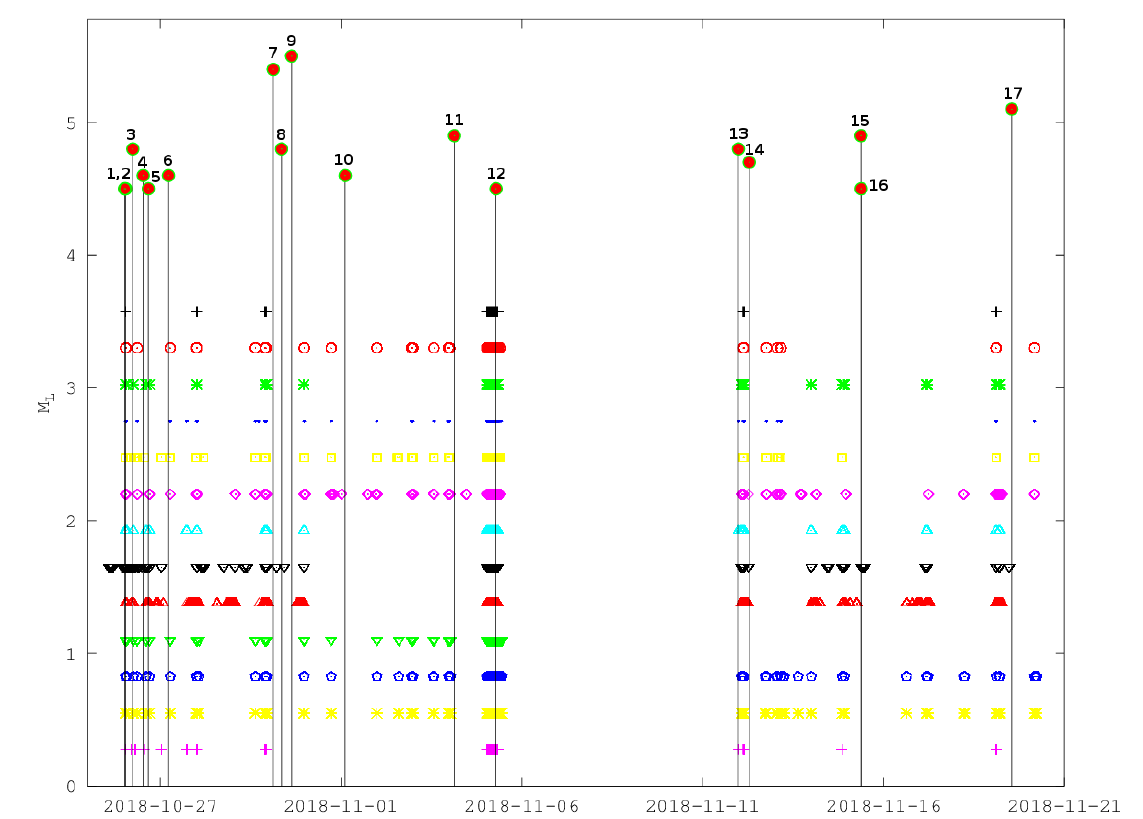
Figure 6. Overview of the full computational meta-analysis results by all 13 selected combinations of chaos analysis methods per five, four, three and two methods. From top to bottom: ‘ + ’ (black): DFA versus all methods (5 techniques); ‘ (cid:12) ’ (red): DFA versus all fractal dimension techniques (4 techniques); ‘ ∗ ’ (green): Fractal analysis versus all fractal dimension techniques (4 techniques); ‘.’ (blue): DFA versus Higuchi’s and Katz’s methods (3 techniques); ‘ (cid:0) ’ (yellow): DFA versus Higuchi’s and Sevcik’s methods